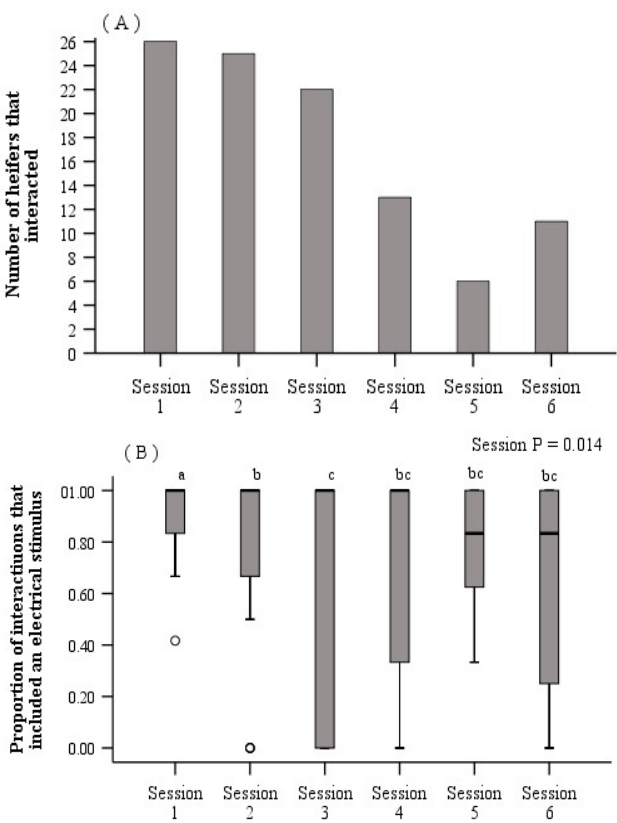
Figure 4. Using data from all heifers and the six training sessions, ( A ) bar chart displaying the number of heifers that interacted with a virtual fence, and ( B ) boxplots of the proportion of interactions with the virtual fence during which an electrical stimulus was delivered. Boxplots show the median and the first and third quartiles (25 and 75% of data), with whiskers extending to the lowest and highest values. Values greater than 1.5 × the interquartile range (IQR) are indicated by օ . Raw means are presented. Estimated marginal means are presented in Table S2. For Figure 4B, training sessions with different superscript letters abc differ at p ≤ 0.05.